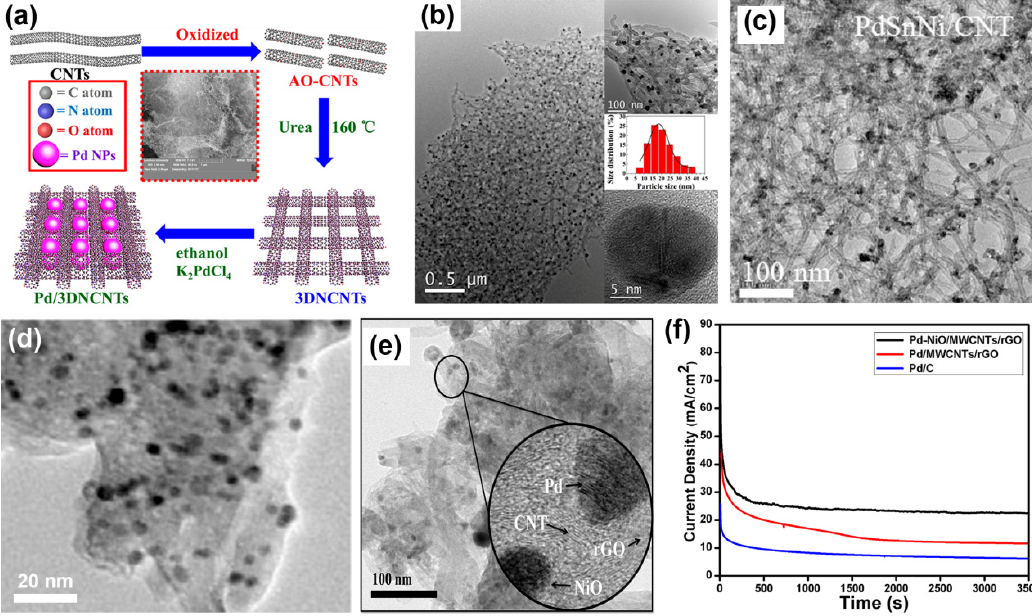
Figure 5. ( a ) Schematic synthetic route of Pd/3DNCNTs catalyst. ( b ) TEM image of Pd/3DNCNTs. The insets correspond to the size distribution histograms and high-resolution TEM images of the lattice structure of Pd nanoparticles. Reproduced with permission from [88] . Copyright 2018, American Chemical Society. ( c ) TEM image of well-distributed PdSnNi nanoparticles anchored on carbon nanotubes (CNTs). Reproduced with permission from [89] . Copyright 2019, Elsevier Ltd. ( d ) TEM image of Pd nanoparticles supported on expanded graphite and multi-walled CNTs. Reproduced with permission from [36] . Copyright 2018, Elsevier Ltd. ( e ) High-resolution TEM image of Pd-NiO/CNTs/reduced graphene oxide (rGO) hybrid catalysts with an enlarged view of the selected area, showing the presence of Pd, CNT and rGO. ( f ) Stability test of ethanol oxidation on Pd/multi-wall